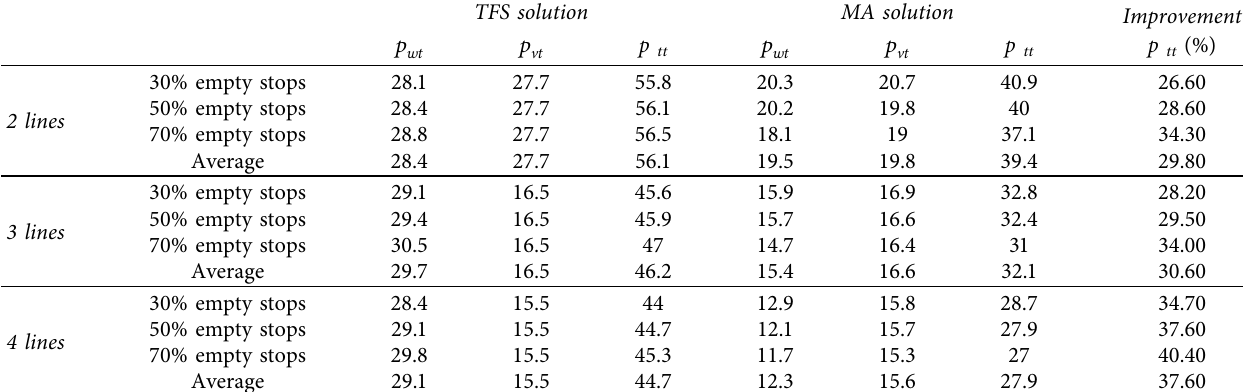
Table 8: Average passenger waiting, in-vehicle, and travel time for 2 or 4 lines. TFS solution MA